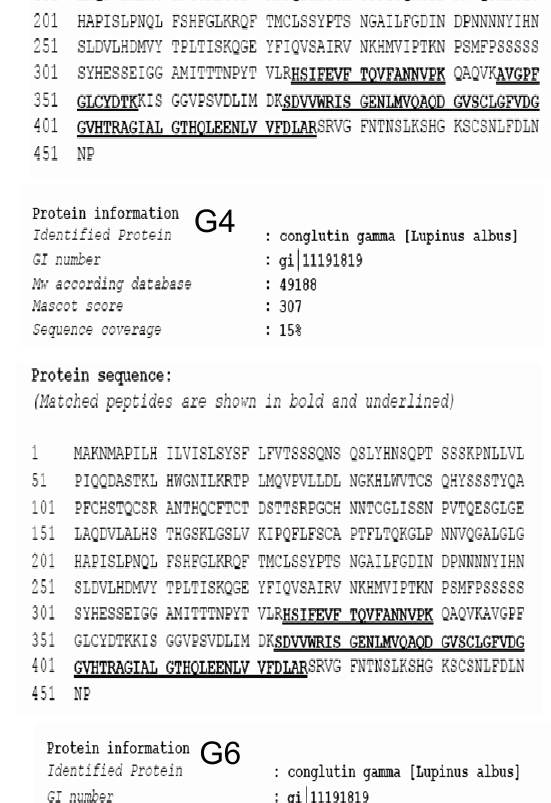
Figure 3. Peptide mass fingerprinting (MALDI-TOF-MS) analysis obtained by LC/MS/MS of the six polypeptide spots (G1 to G6) detected in Figure 1C.